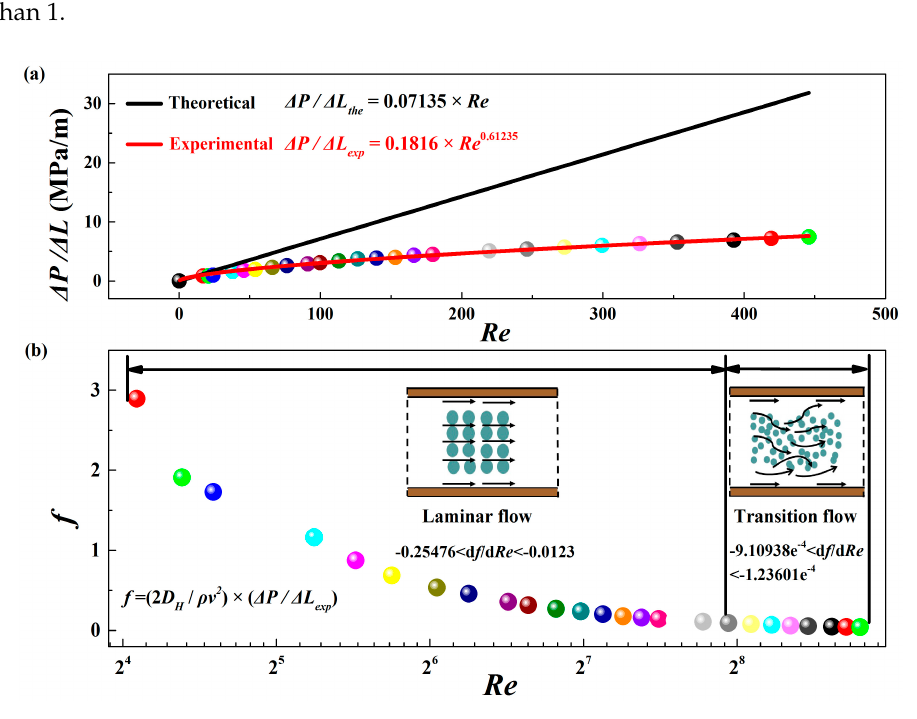
Figure 5. ( a ) The curve for the pressure gradient as a function of Re ; ( b ) The flow resistance versus Re for the single flow in microchannel.